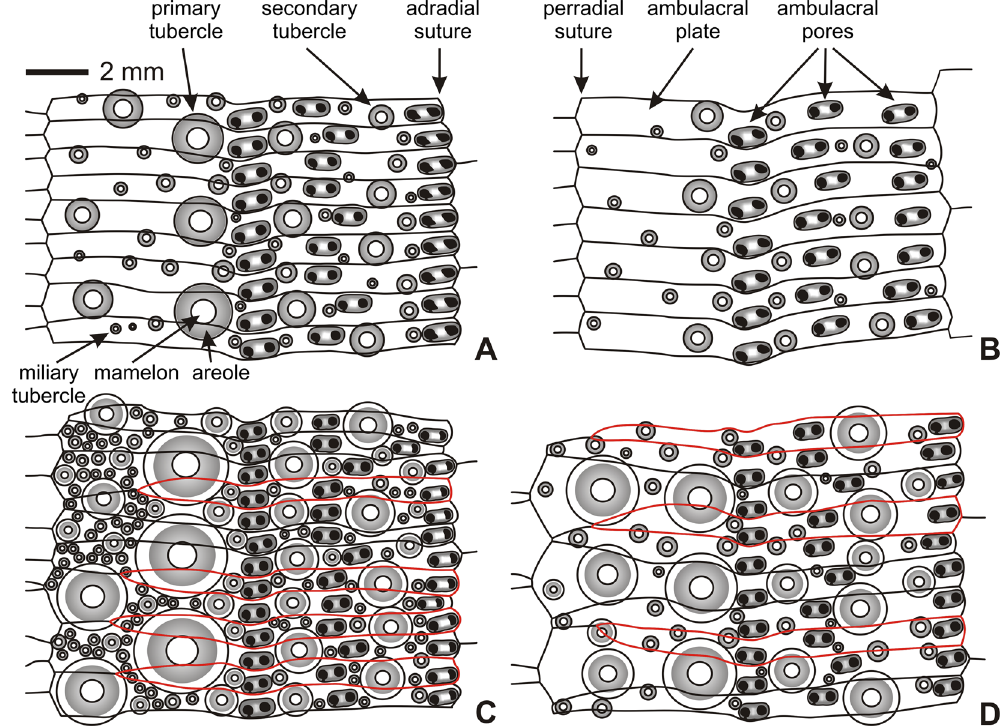
Figure 4. Ambital ambulacral plating of Tripneustes species. ( A ) Tripneustes gratilla gratilla (TD = 90.7 mm; Phatthaya, Thailand; NHMW-Geo 2011/0352/0003); ( B ) Tripneustes gratilla elatensis (TD ~95 mm; Ras Abusoma, Safaga, Egypt; NHMW-Geo 2008z0004/0012); ( C ) Tripneustes kermadecensis n. sp. (TD = 94.5 mm; Meyer Islands, New Zealand; holotype AIM MA73563); ( D ) Tripneustes ventricosus (TD ~100 mm; Roatan Island, Honduras; NHMW-Geo 2008z0167/0016). Plates occluded from perradial suture highlighted in